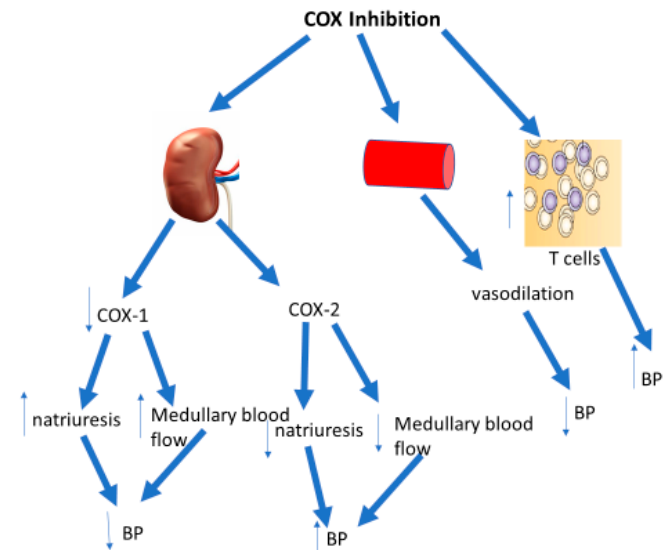
Figure 1. COX inhibition decreases or increases BP through inhibition of renal COX-1 or COX-2 respectively. However, the overwhelming effect of COX inhibition in the vasculature is vasodilatory. Finally, we have shown systemic COX inhibition may increase BP through activation of T cells and promotion of their infiltration into cardiovascular organs.